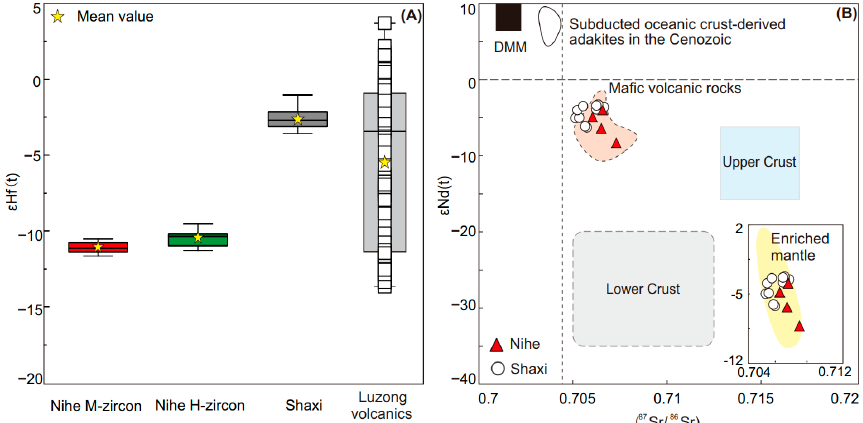
Figure 9. Box plot for zircon ε Hf(t) of the porphyry in Nihe and Shaxi ( A ). For comparison, the basaltic andesites of the Zhuanqiao Formation at the Luzong Cretaceous volcanic basin [55], Lower Yangtze Valley, are also shown. Initial 87 Sr/ 86 Sr vs ɛ Nd(t) plot of the porphyries in Nihe and Shaxi ( B ). Data sources for the Cenozoic adakites attributed to the melting of the subducting oceanic crust are from Wang et al. [56], and those for the enriched mantle are from Xie et al. [57]. Abbreviations: M-zircon = magmatic zircon, H-zircon = hydrothermal zircon.